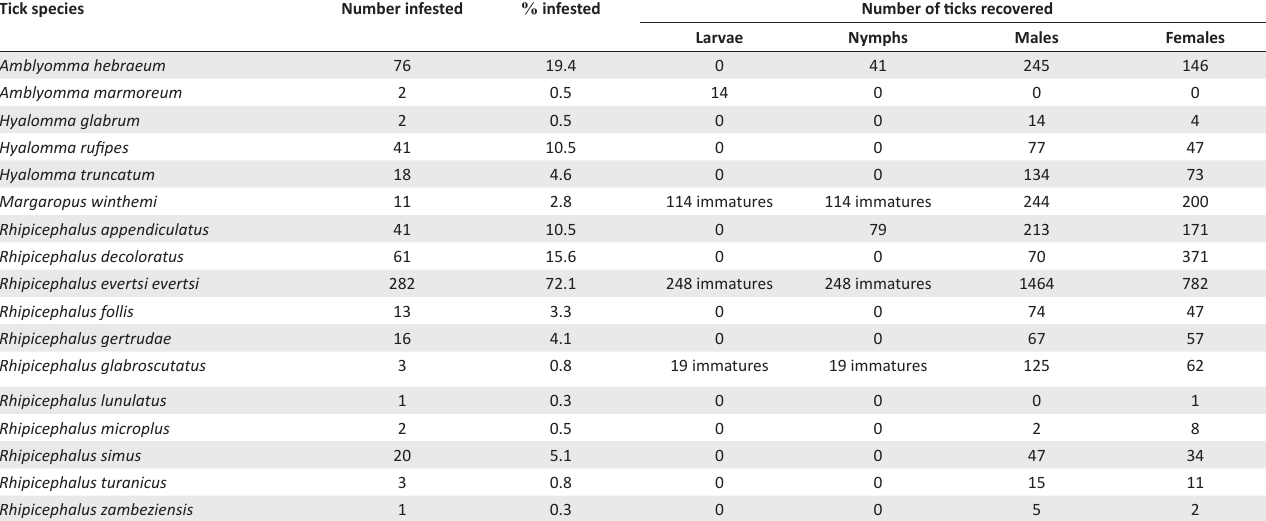
TABLE 1: Ticks collected from 391 horses throughout South Africa. Tick species Number